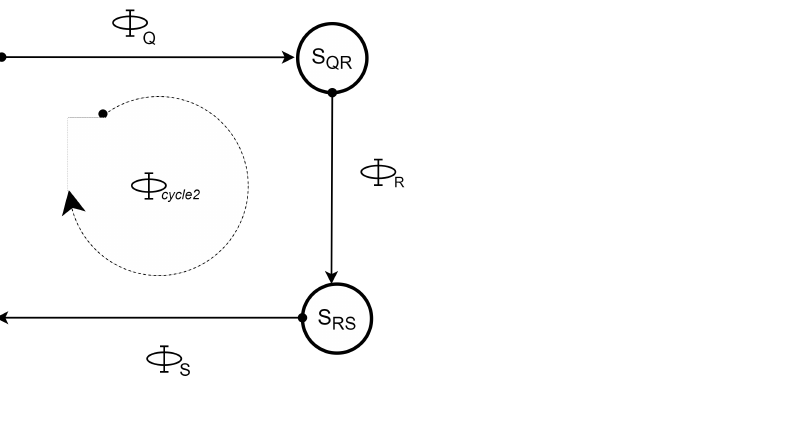
Figure 8. Diagram of the transition matrices and the saltation matrices in faulty switching case h 3 = 0, h 1 = h 2 = 1.